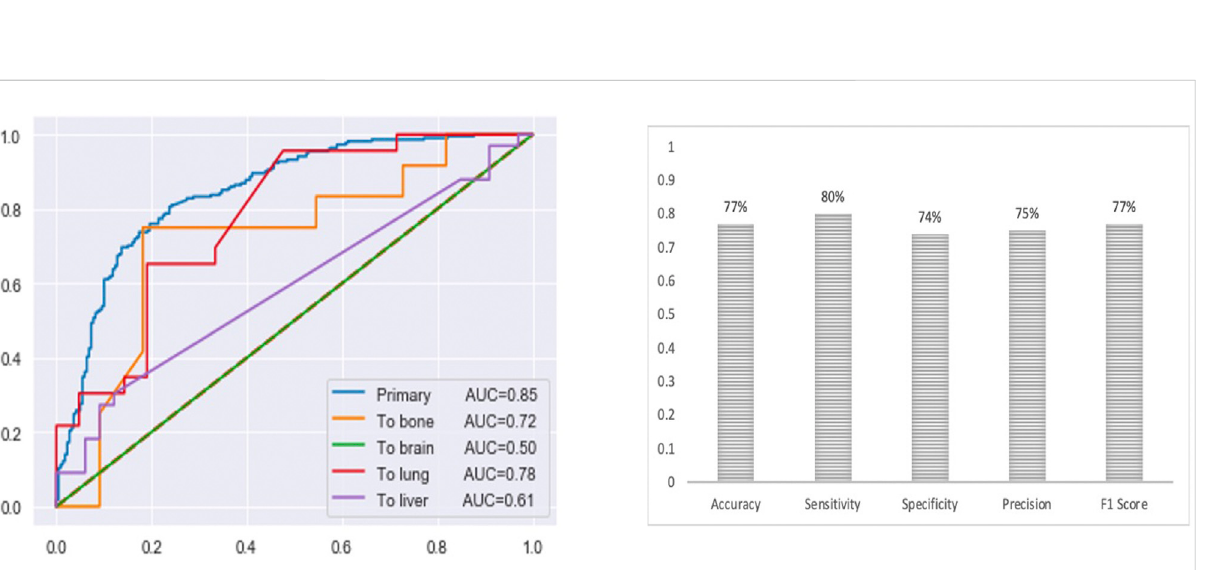
FIGURE 6 Thepredictionperformanceofthe fi nalmulti-classDNNmodelusingexternaltestingdatafromtheTCGAdatasets.Note,forthebrainthereare only 2 samples in the test